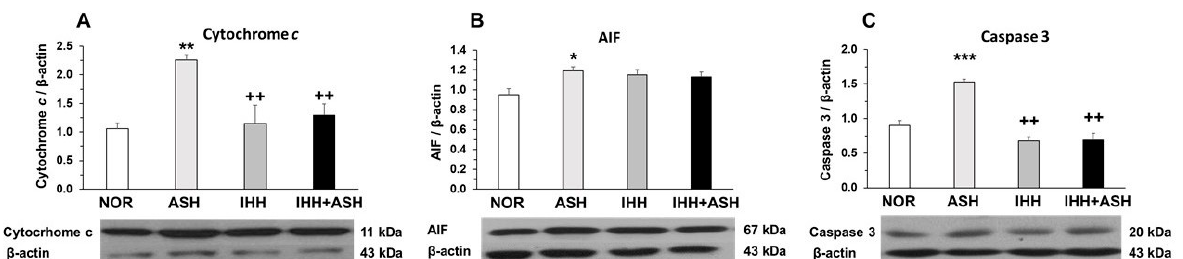
Figure 2. Mitochondrial apoptosis-related markers. Examples of Western blots bands normalized to β -actin (with each corresponding well) are shown. Units are expressed relative to the β -actin content. ( A ) cytochrome c ; ( B ) AIF, apoptosis- inducing factor; ( C ) caspase-3. Statistically significant differences between groups are presented with asterisks (*, vs. NOR) or crosses (+, vs. ASH). One symbol indicates p < 0.05, two symbols p < 0.01 and three symbols p < 0.001. F-values after running one-way ANOVAs with Bonferroni’s post hoc multiple comparison tests were: F = 4.29 (cytochrome c ), F = 2.93 (AIF) and F = 1.61 (caspase 3). Animal experimental groups are abbreviated as NOR, normoxic; ASH, acute severe hypoxia; IHH, intermittent hypobaric hypoxia; IHH+ASH, intermittent hypobaric hypoxia followed by acute severe hypoxia.